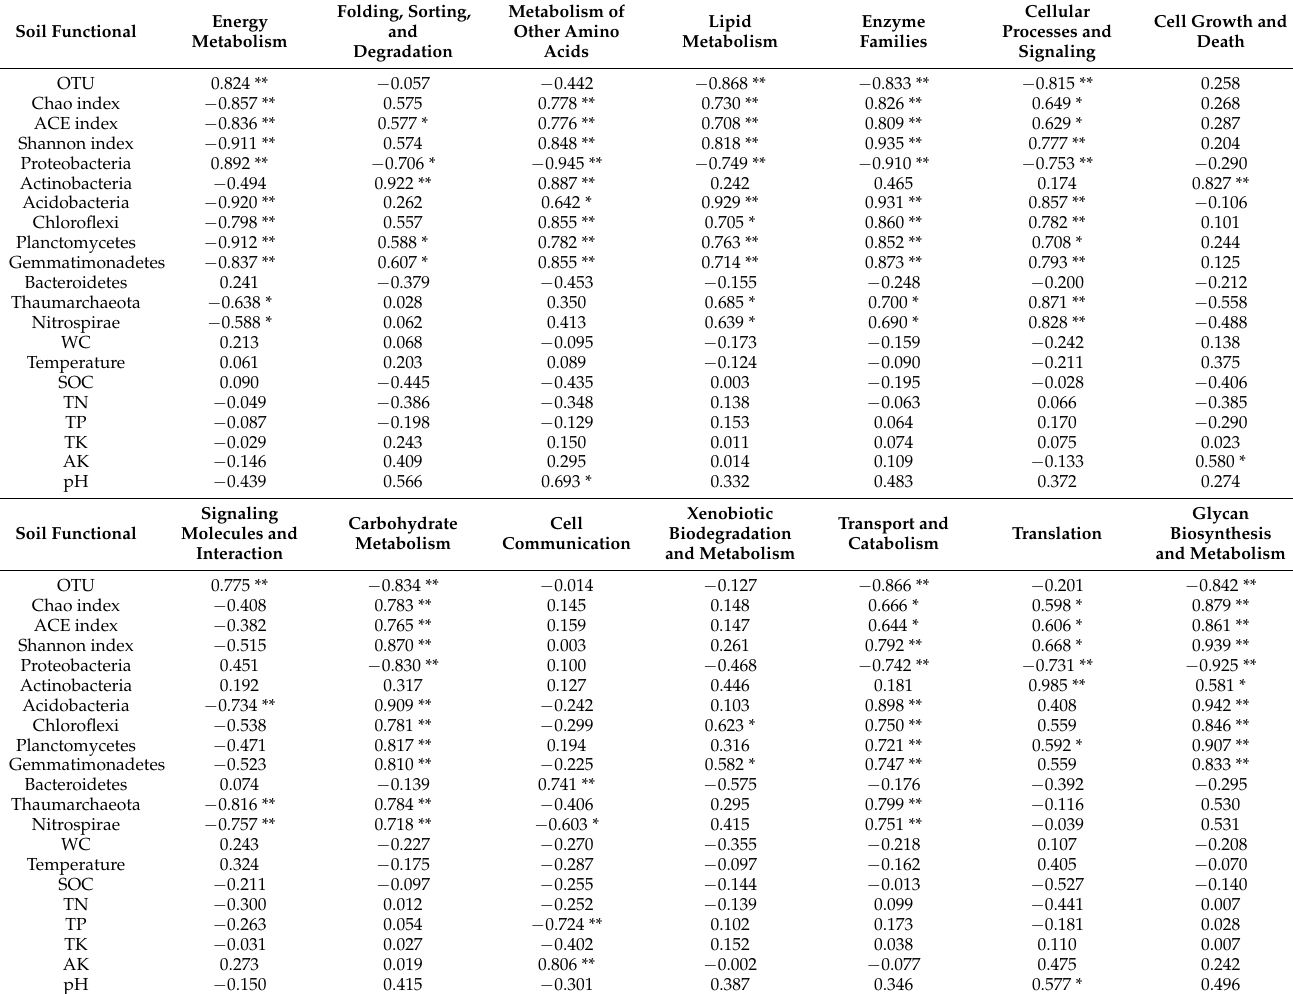
Table 4. Correlation among functional abundance, soil bacterial community, and soil factor